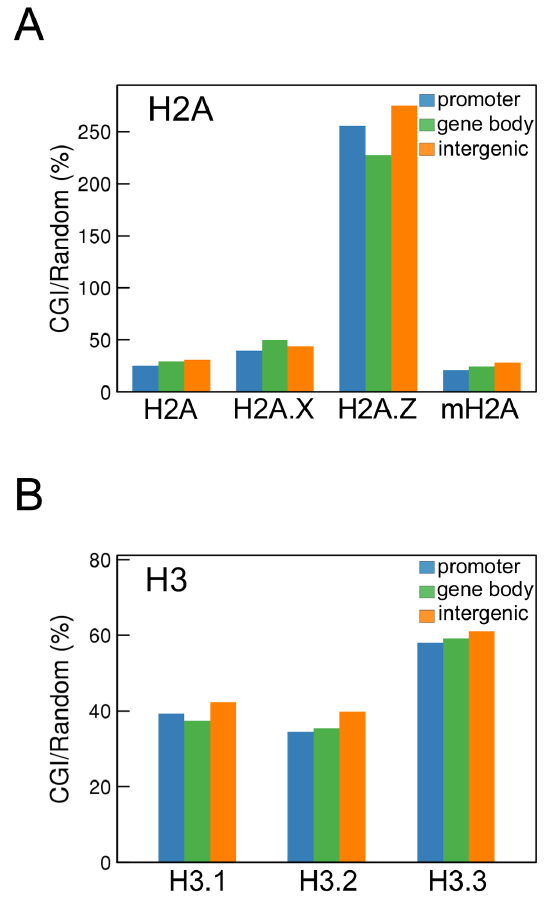
Figure 5. Enrichment of histone variants in CpG islands (CGIs). The enrichment of histone H2A (A) and H3 (B) variants in CGIs defined in the UCSC Genome Bioinformatics Site was determined in promoters (blue), gene bodies (green), and intergenic regions (orange). The ratios (%) of the enrichment in CGIs to the averaged enrichment in 5,000 randomly selected 656-bp regions, which is the average length of all CGIs analyzed, from the whole genome excluding CGIs were calculated.